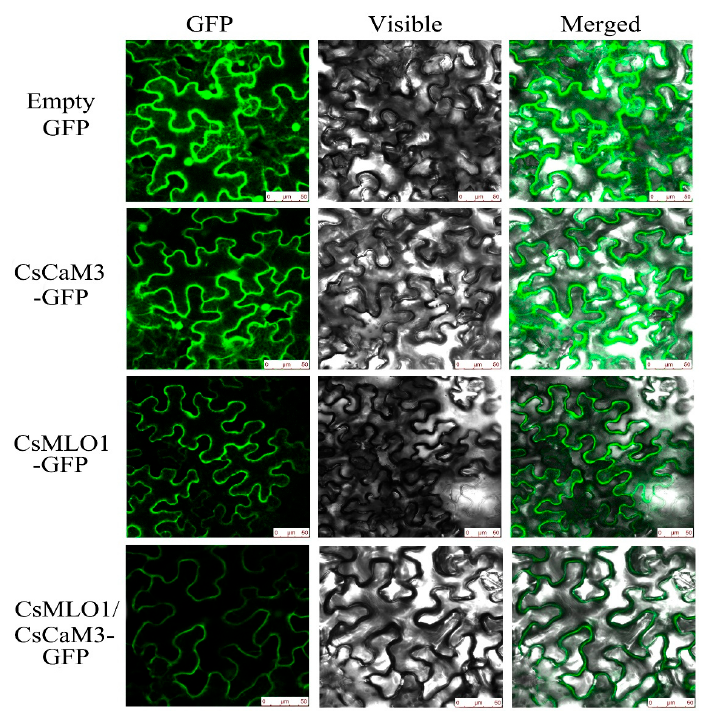
Figure5. Subcellularlocalizationanalysesof CsCaM3 -GFP, CsMLO1 -GFP,and CsCaM3 -GFP + CsMLO1 -GFP Figure 5. Subcellular localization analyses of CsCaM3 -GFP, CsMLO1 -GFP, and CsCaM3 - GFP+ CsMLO1 -GFP in transiently transformed N. benthamiana leaves. Confocal images of green in transiently transformed N. benthamiana leaves. Confocal images of green fluorescent protein (GFP), fluorescent protein (GFP), CsCaM3 -GFP, CsMLO1 -GFP, and CsCaM3 -GFP+ CsMLO1 -GFP in N. CsCaM3 -GFP, CsMLO1 -GFP, and CsCaM3 -GFP + CsMLO1 -GFP in N. benthamiana epidermal cells 3 days benthamiana epidermal cells 3 days after Agroinfiltration . Bars = 50 μ m. after Agroinfiltration . Bars = 50 µ m. Int. J. Mol. Sci. 2019 , 20 , x FOR PEER REVIEW